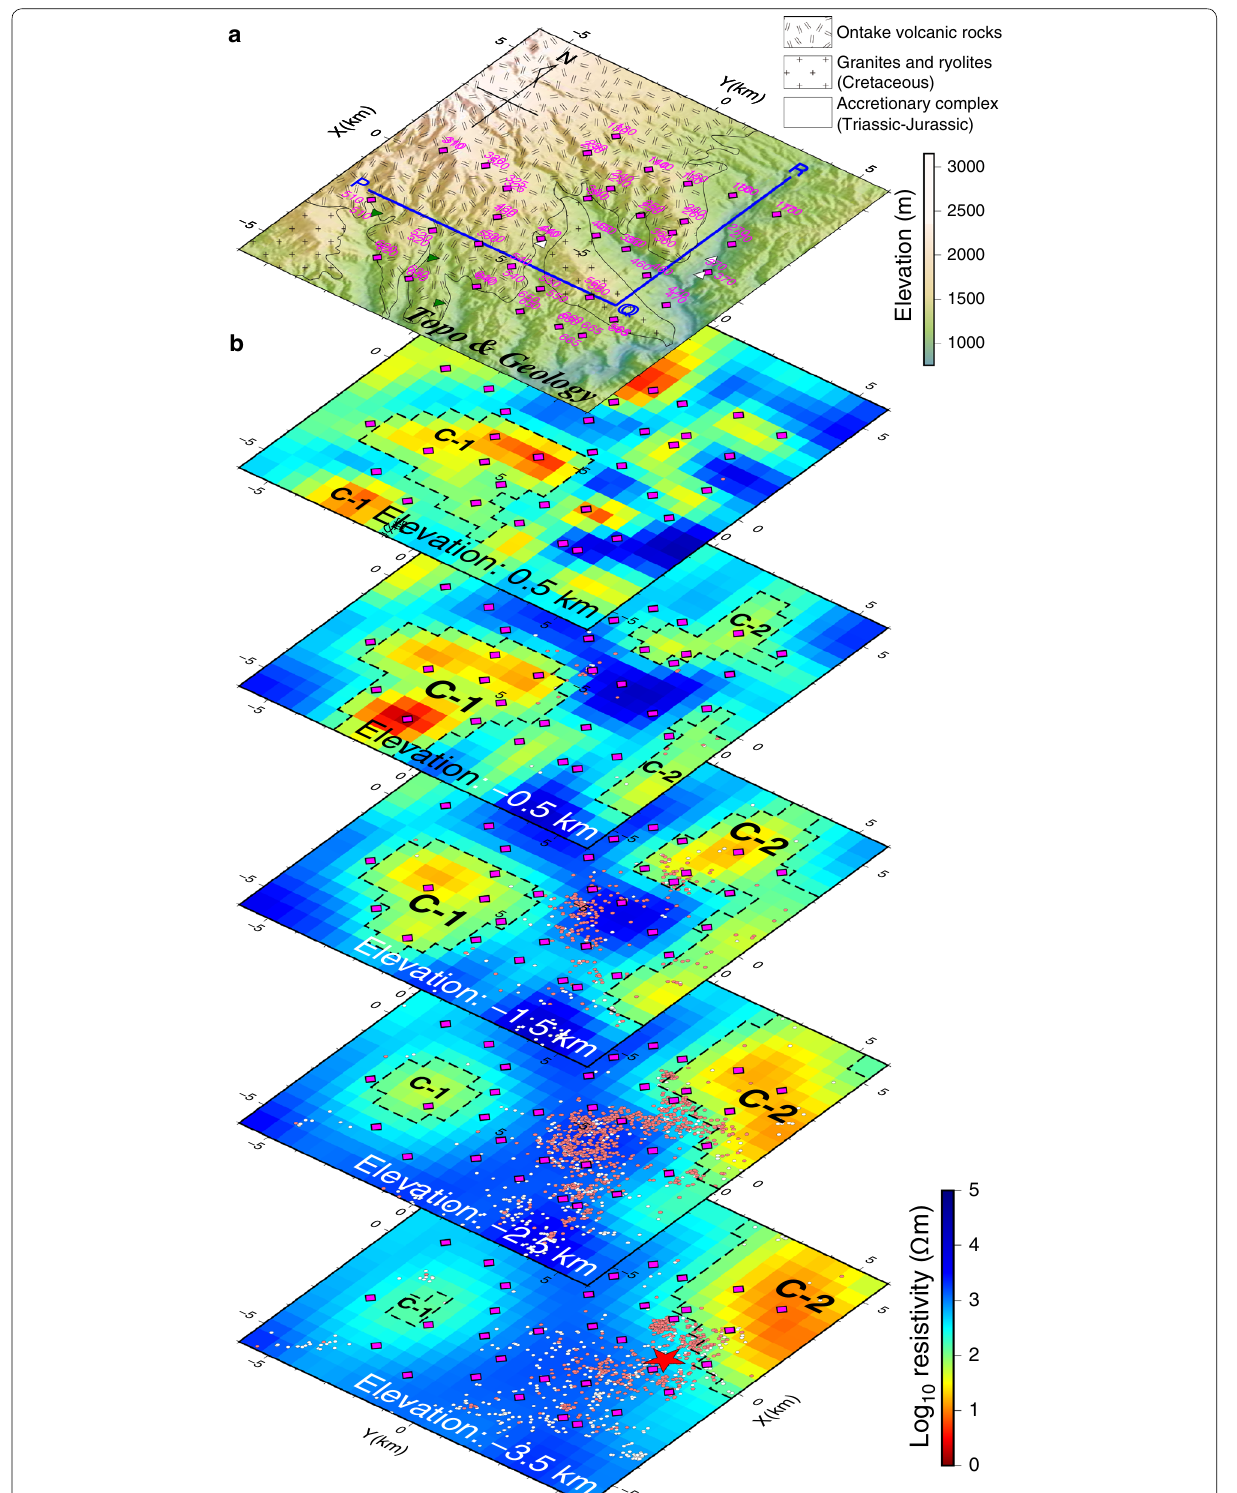
Fig. 4 a Topographic map with surface geology based on (Geological Survey of Japan 2015) b Horizontal cross section of the inverted 3D resistivity model. Magenta diamonds denote MT sites. Circles denote hypocenter locations of earthquakes that occurred between 2012 and 2017, manually estimated by Nagoya University (2017). Red and white circles indicate epicenters before and after the M JMA 5.6 earthquake on June 25, 2017, respectively. Area enclosed by white dashed lines shows the uniformly filled area with 300 Ω-m in the sensitivity tests. Note that only model blocks with resistivity less than 300 Ω-m are filled in the tests. Elevations are defined relative to sea